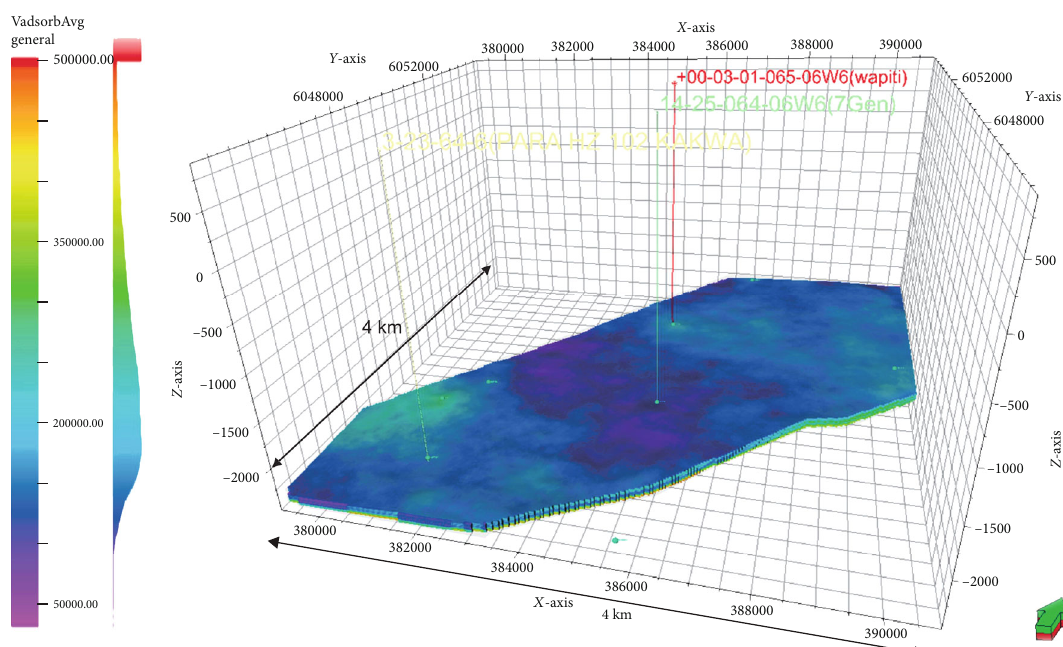
Figure 10: The three-dimensional model of the middle area using three wells. The desorbed gas volume shows highest toward the central region (near the UWI 100142506406W600) and lowest in northwestern region (near the UWI 100030106506W600).